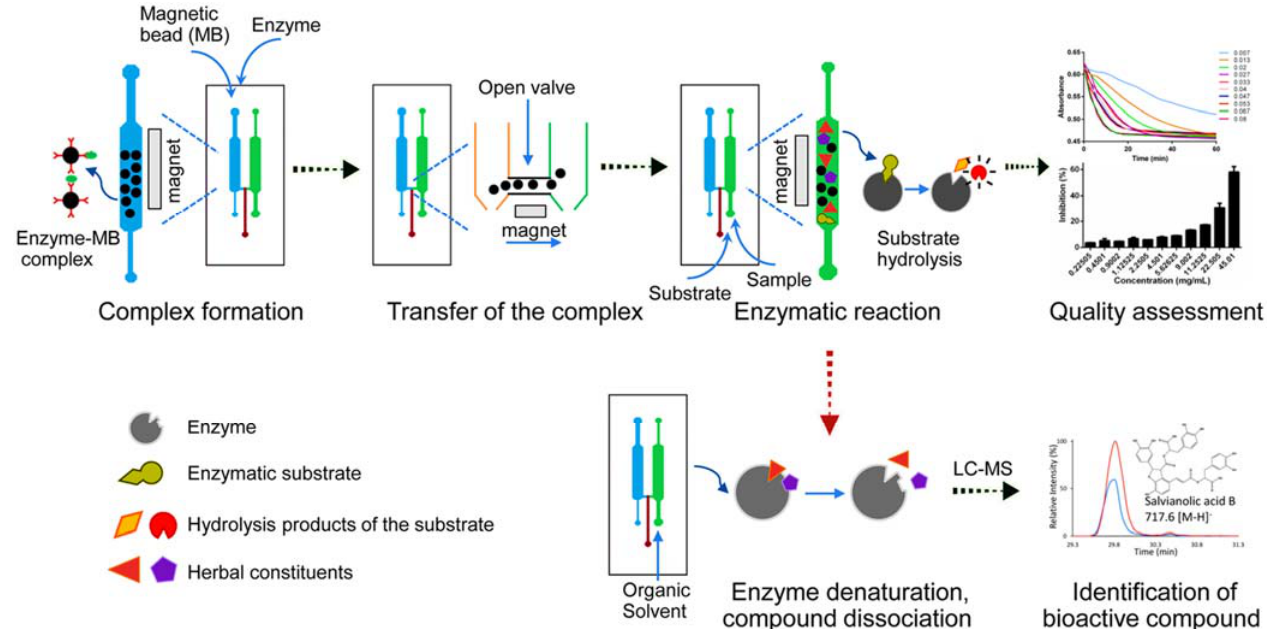
Figure 12. Schematic diagram of biopharmaceutical quality assessment and screening on a Micro ‐ fluidic chip. The image from [2], Copyright 2017, Scientific Reports.